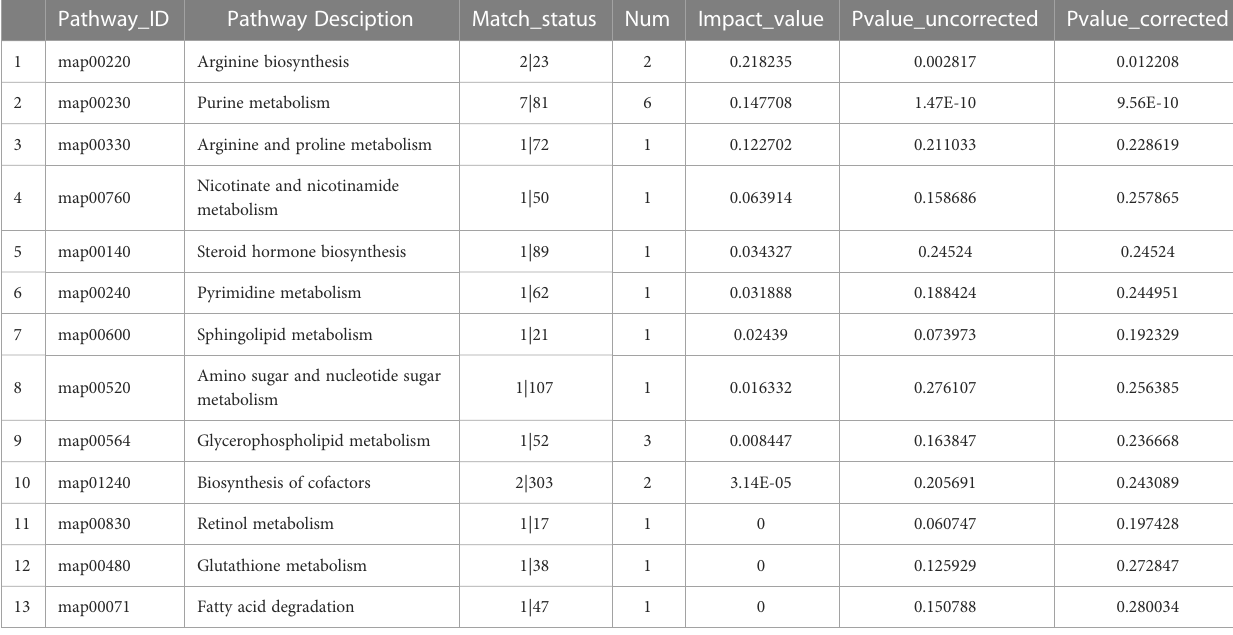
TABLE 4 Metabolic pathway KEGG topology